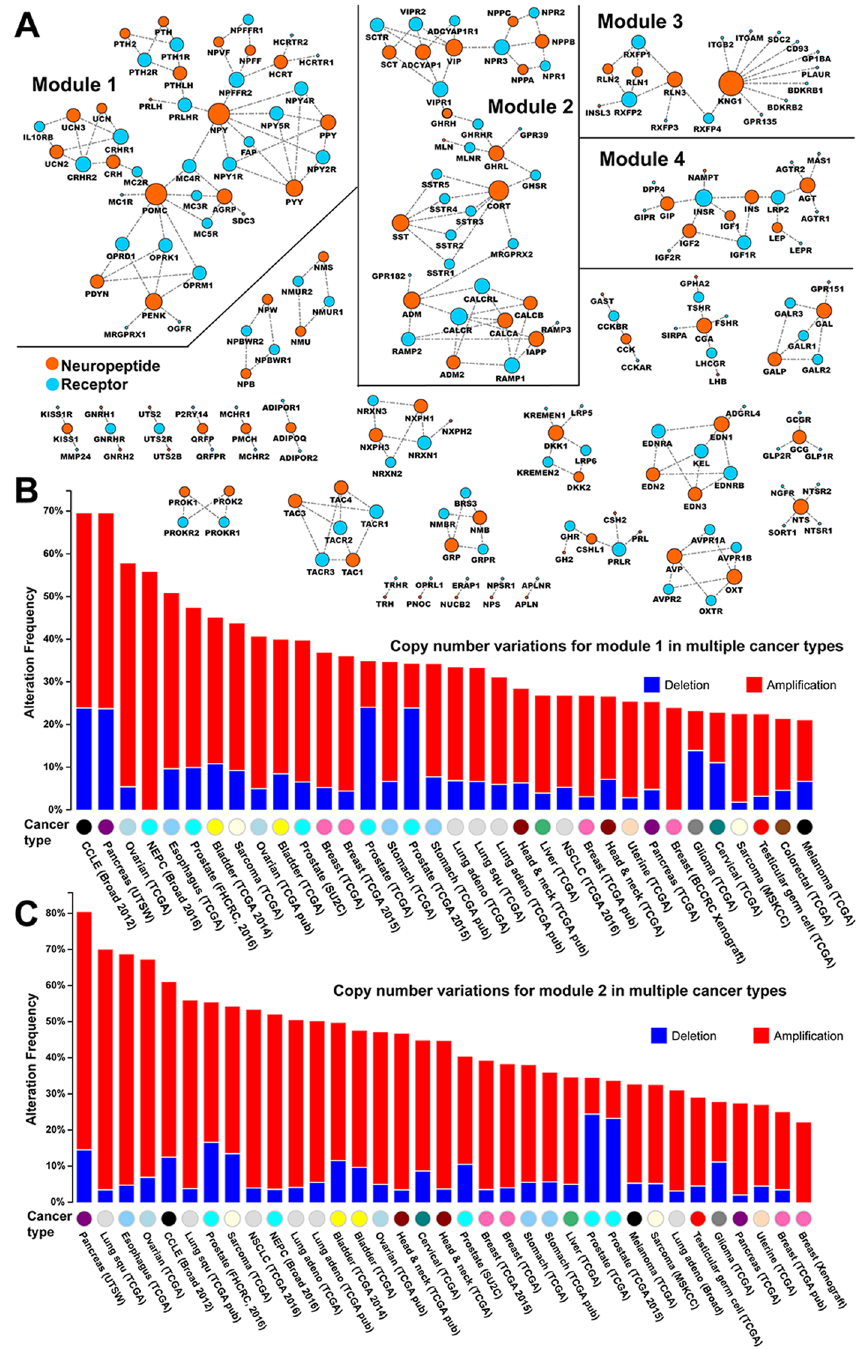
Figure 3. Functional modules in the interaction map for the 93 neuropeptides and 133 receptors. ( A ) The 93 genes in orange are neuropeptides. The other 133 receptor genes are in blue. The links between any two nodes represent the interactions. The size of the nodes represents the number of the connections. The top four connected modules are separated. ( B ) The global copy number variation for all the 44 genes in module 1 across multiple cancer dataset. ( C ) The global copy number variation for all the 39 genes in module 2 across multiple cancer